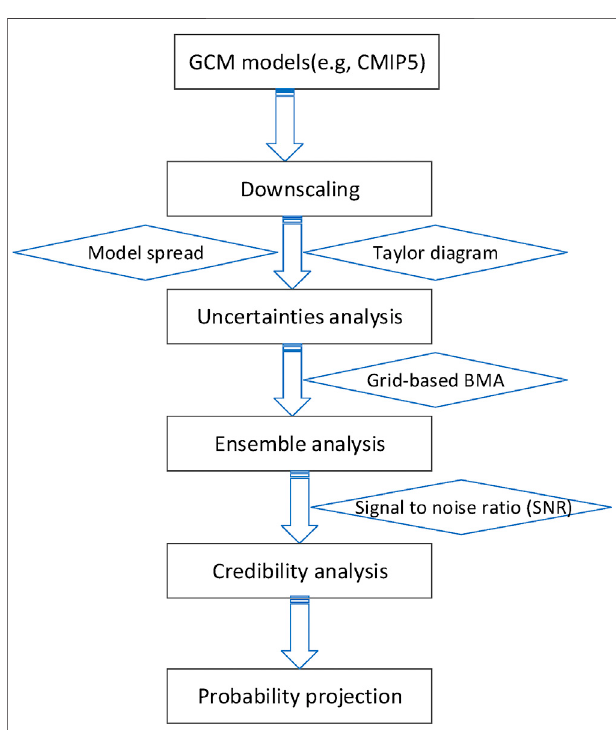
FIGURE 2 | Framework to identify the uncertainty and credibility of